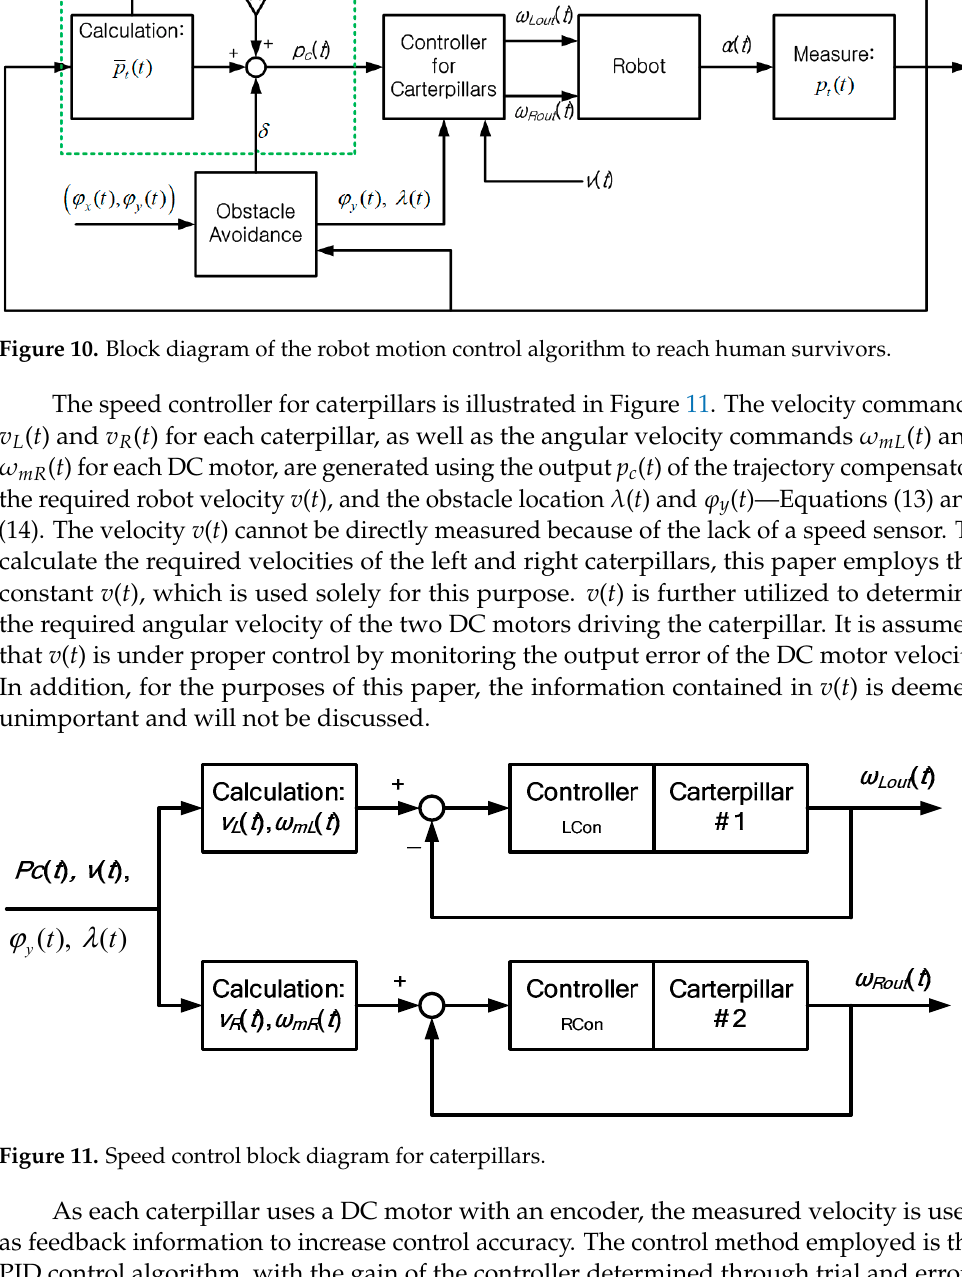
Figure 12. Position control block diagram for a linear actuator. 4. Experiment 4.1. Experiental Setup To evaluate the effectiveness of the proposed method, a prototype robot system was built as illustrated in Figures 1 and 2 and shown in Figure 13. The prototype features a single linear actuator and storage box, as shown in Figures 6 and 9, and is powered by